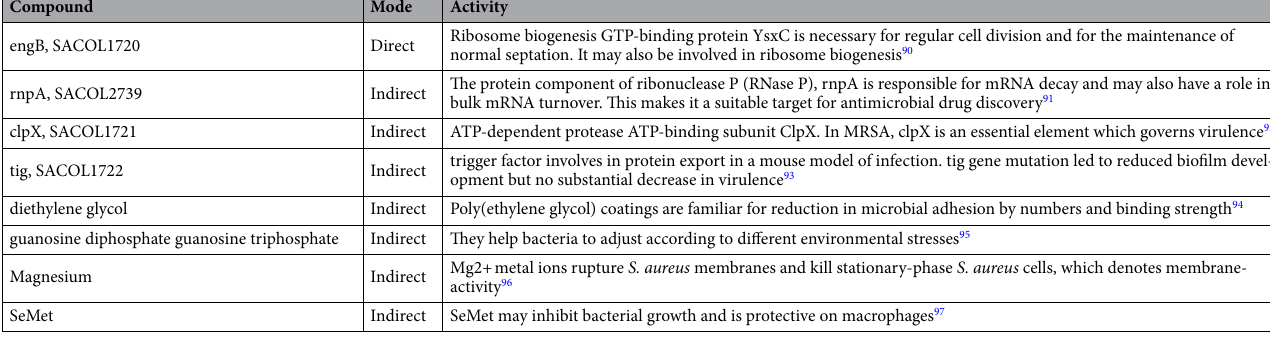
Table 6. Effect of benzothiazole (BT) on